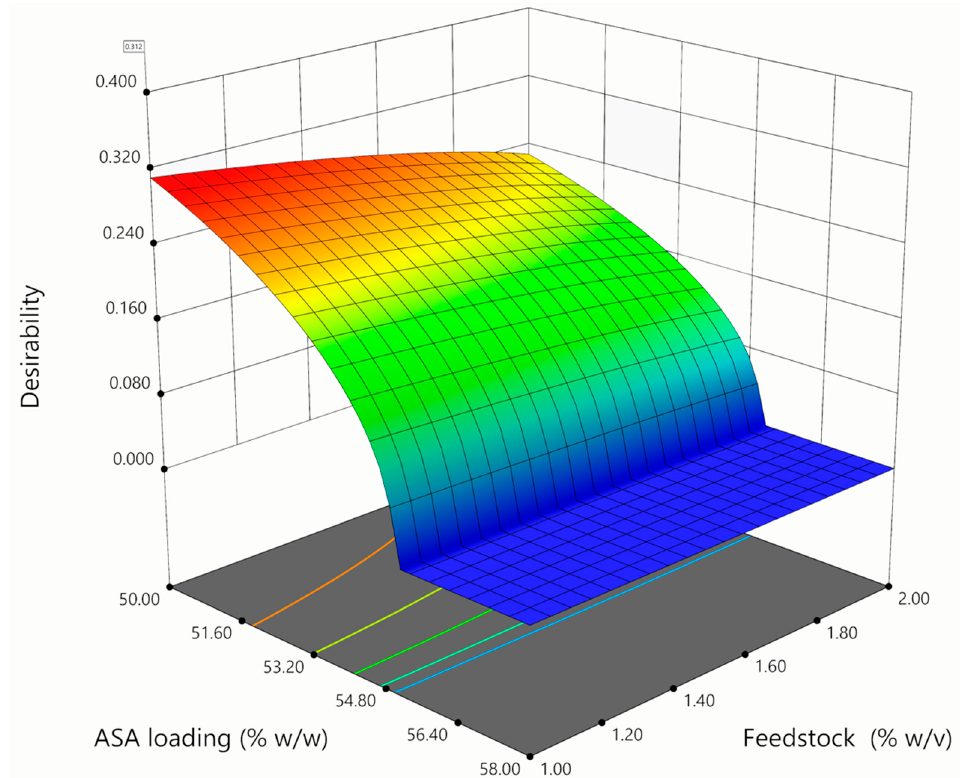
Figure 4. Desirability plot indicating the area of satisfaction (red-shaded) of the defined target properties of the obtained ASA inhalable powders: process yield ≥ 50%, ED ≥ 90%, FPF ≥ 50%, and ASA content ≥ 40%. Satisfaction of FPF and ED criteria was prioritized over the other responses. Maximum desirability was obtained at T inlet = 85 °C.